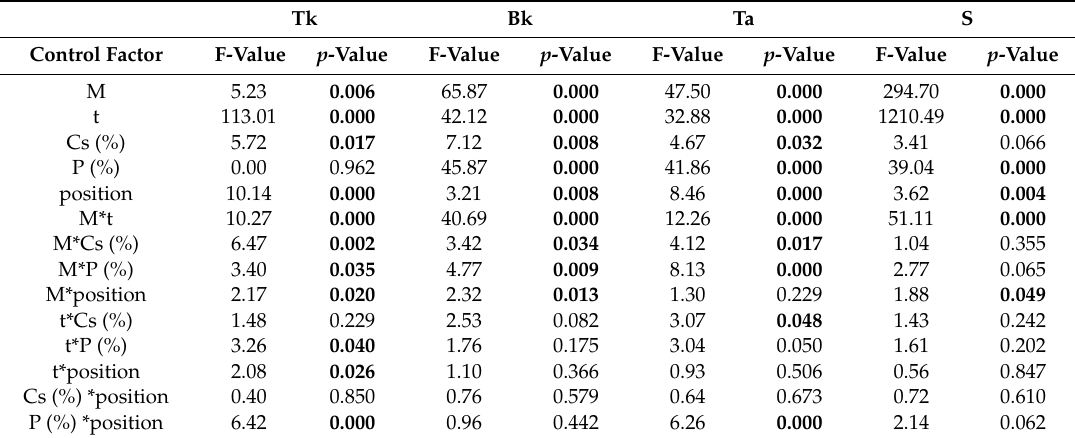
Table 6. ANOVA results for geometrical variables, computed F-value and p